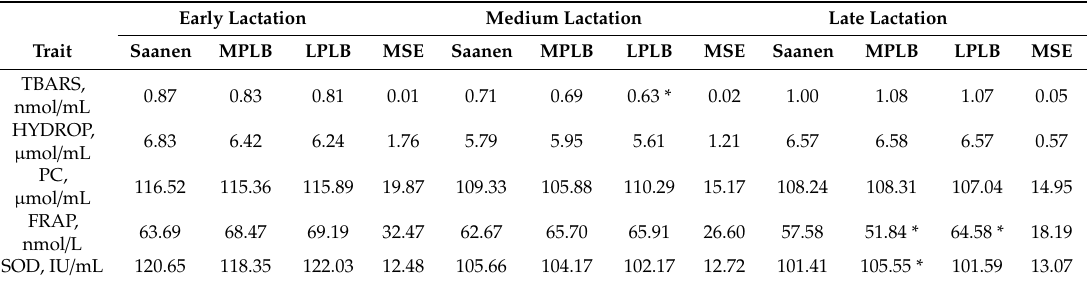
Table 4. Plasma oxidative profile (least squares means and mean standard error) of Saanen breed compared with Mediterranean medium production level breeds (MPLB: Maltese and Jonica breeds) and low production level breeds (LPLB: Rossa Mediterranea, Girgentana, and Garganica breeds) during early lactation (2–4 weeks in milking), medium lactation (5–10 weeks in milking), and late lactation (11–30 weeks in